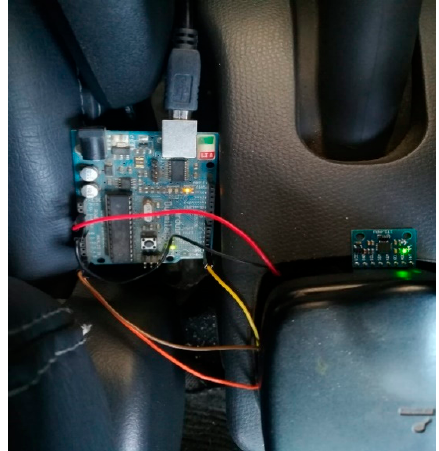
Figure 17. Experimental setup containing Arduino and MPU6050 .